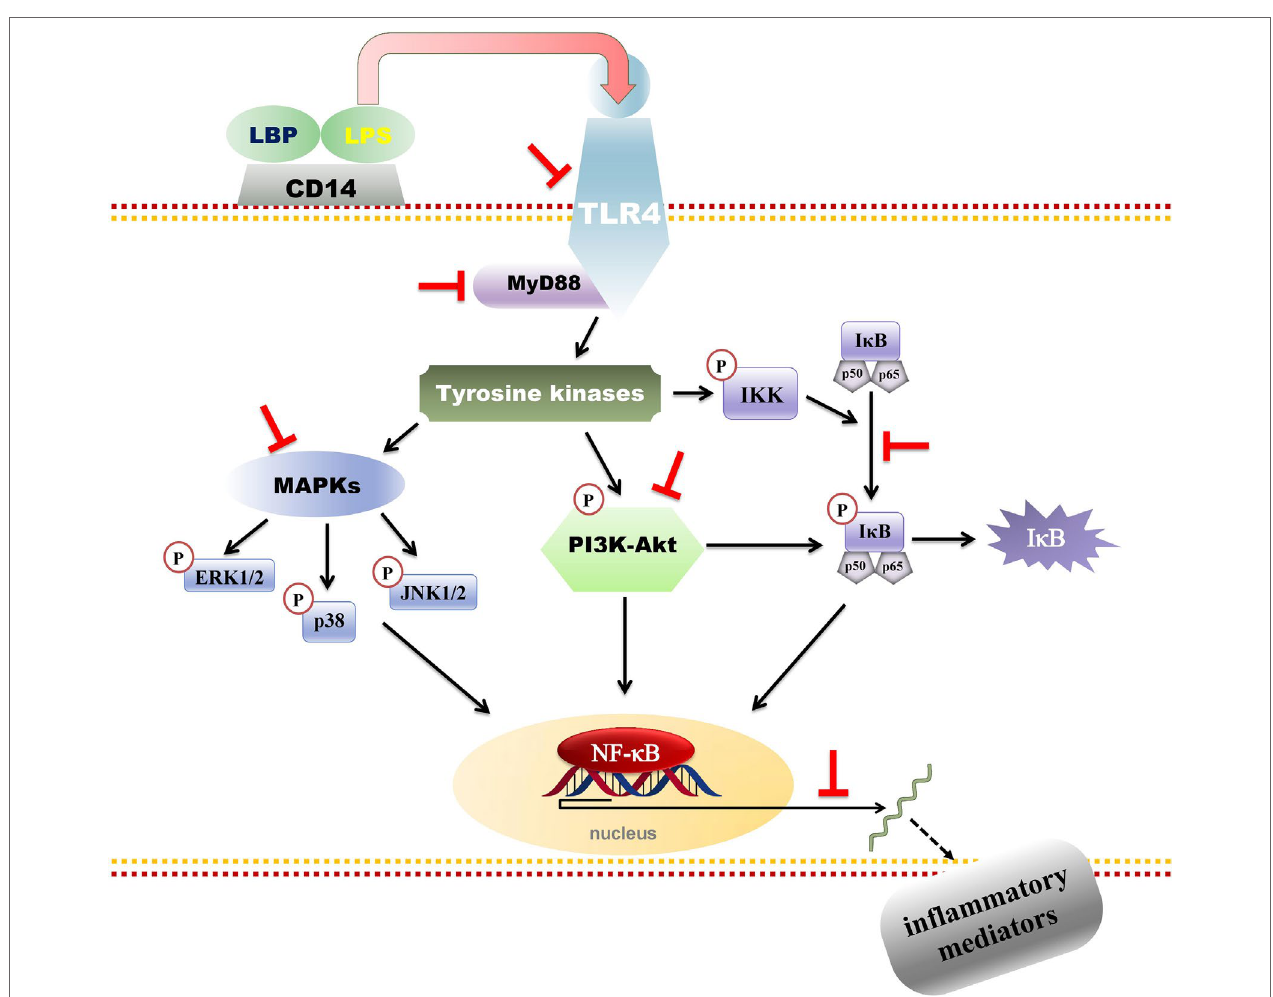
FIGURE 4 | Phyllanthin-mediated inhibition of lipopolysaccharide (LPS)-induced inflammatory responses through NF- κ B, MAPKs, and PI3K-Akt signaling pathways in human